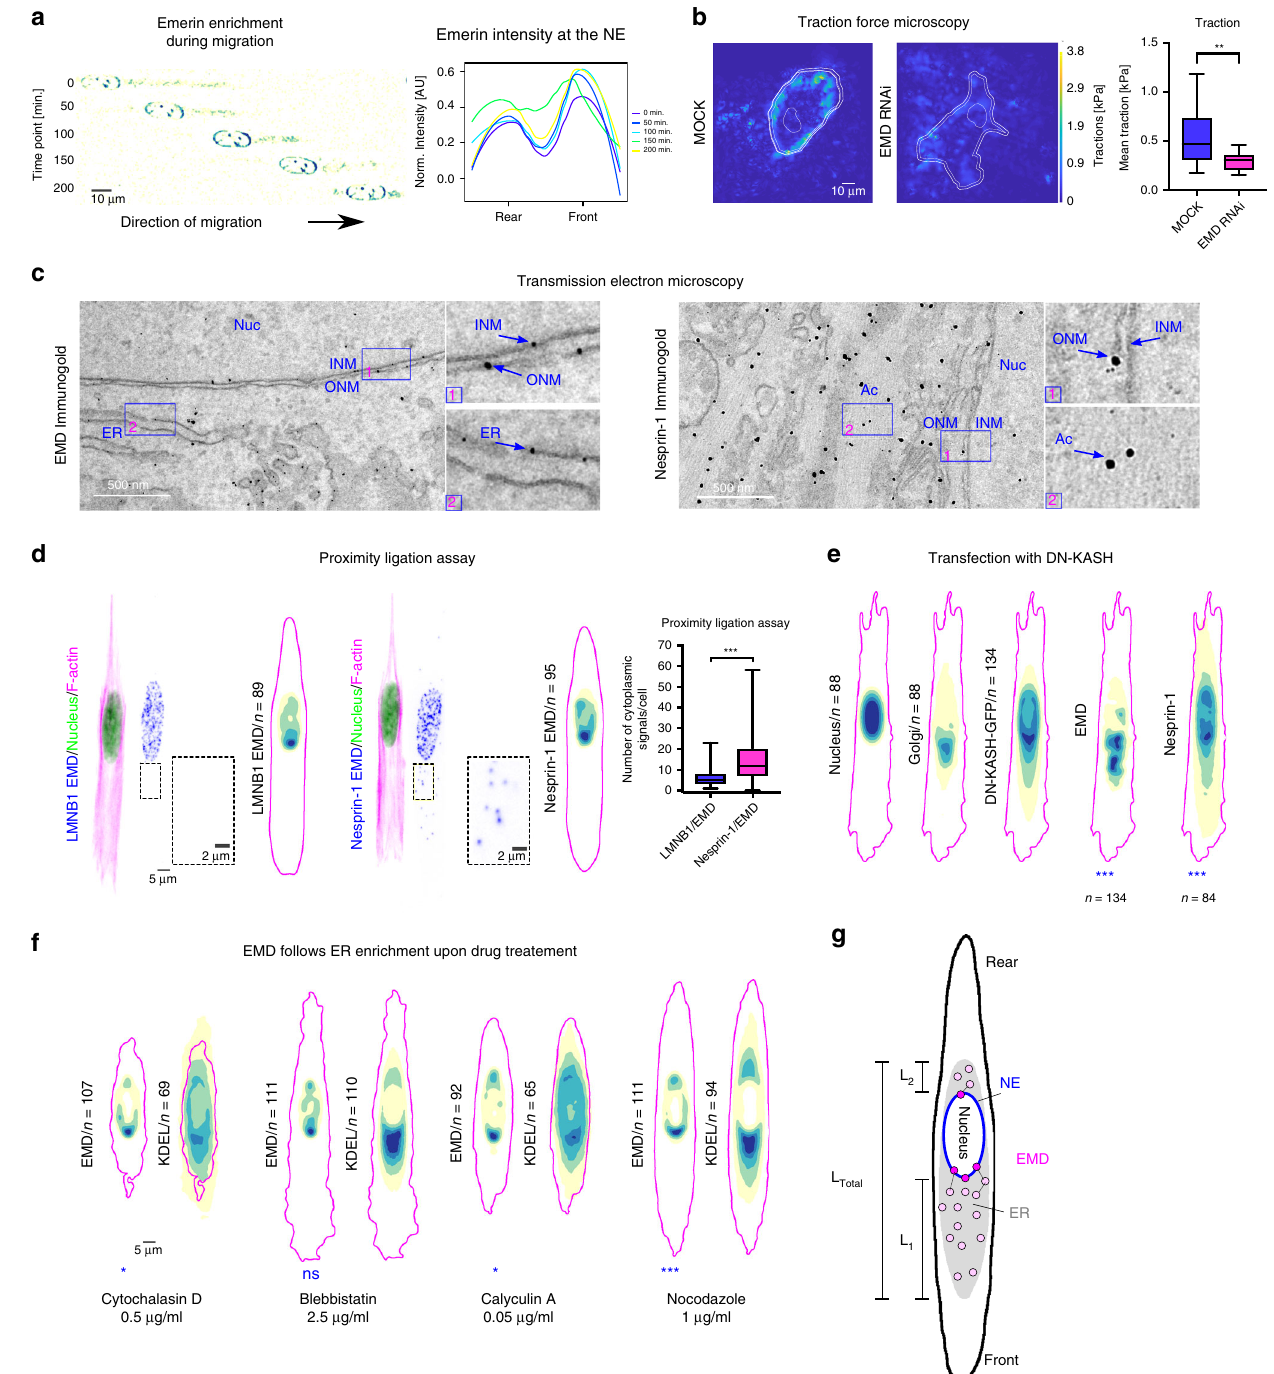
(Fig. 4e; Supplementary Fig. 6g). We showed that perturbing the connection between the cytoskeleton and the nucleus, alters nuclear polarity. Nuclear polarity persists upon drug treatment . In order to test whether nuclear polarity can be altered by affecting cytoskeleton components, we incubated micro-patterned cells with different agents including cytochalasin D (prevents actin polymeriza- tion 44 ), blebbistatin (inhibits myosin 45 ), calyculin A (enhances myosin 46 ), nocodazole (prevents microtubule polymerization 47 ). Although all drug treatments clearly affected both